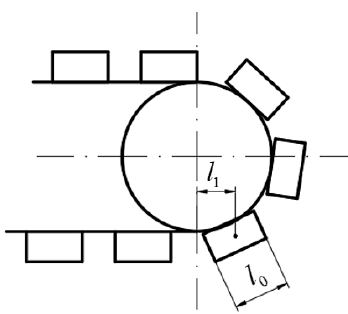
Figure 5. The position of the lowest magnetic unit which is disengaging with the surface.